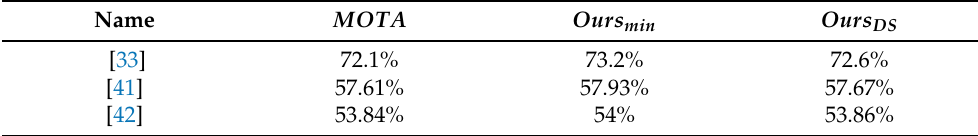
Table 6. Compare our work with a state-of-the-art algorithm on KITTI raw